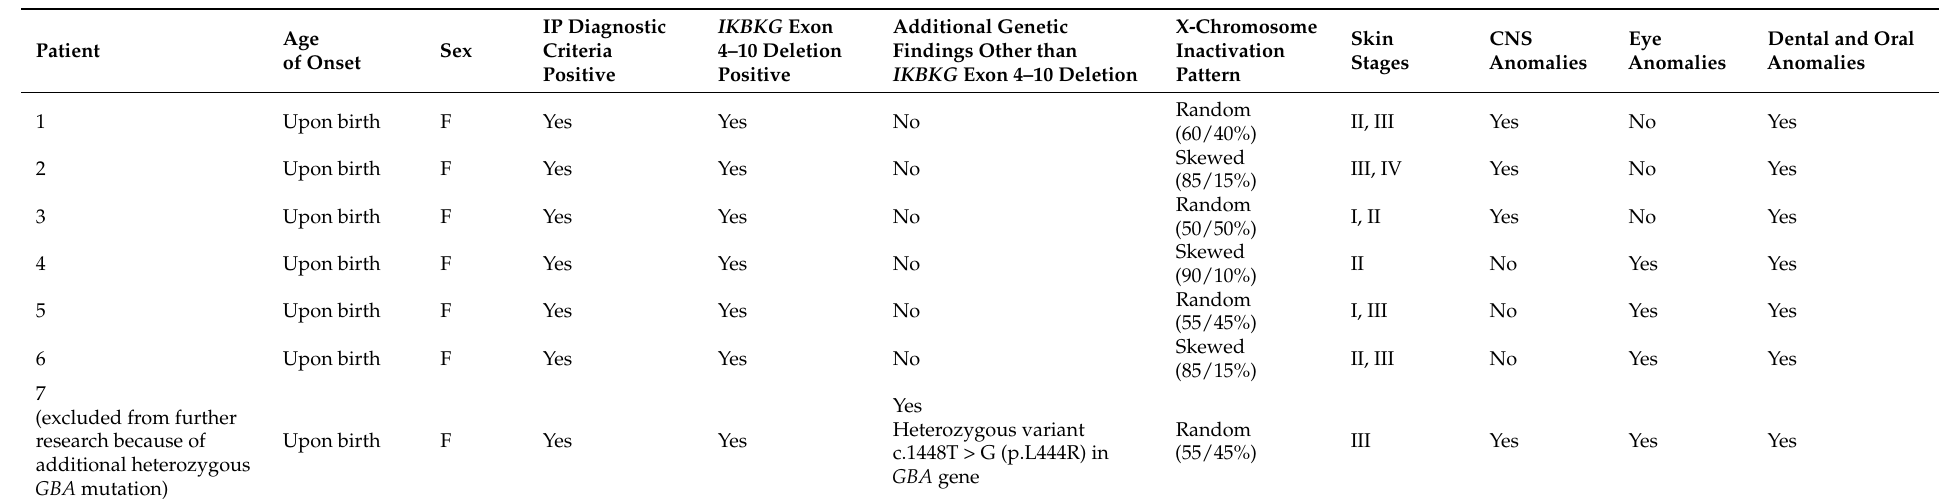
Table 1. Facts concerning basic patient data and key clinical findings.